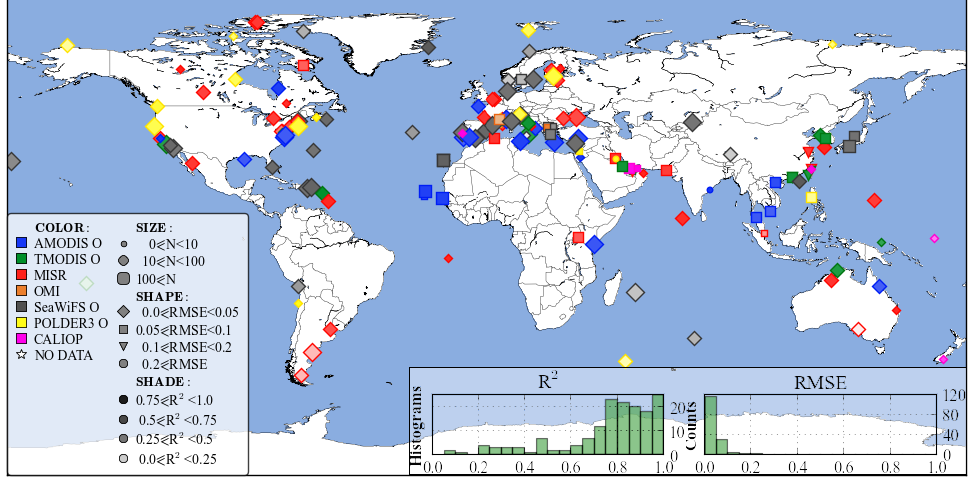
Fig. 12. Spaceborne datasets with the best root mean square error (RMSE) of the retrieved AOD to the AOD measured by each individual inland (top) and coastal or island-based (bottom) AERONET site. The symbols used are the same as the symbols in Fig. 11. The statistics were calculated based on the data that were pre-filtered by QA and screened of outliers as described in Sects. 4 and Section 5.